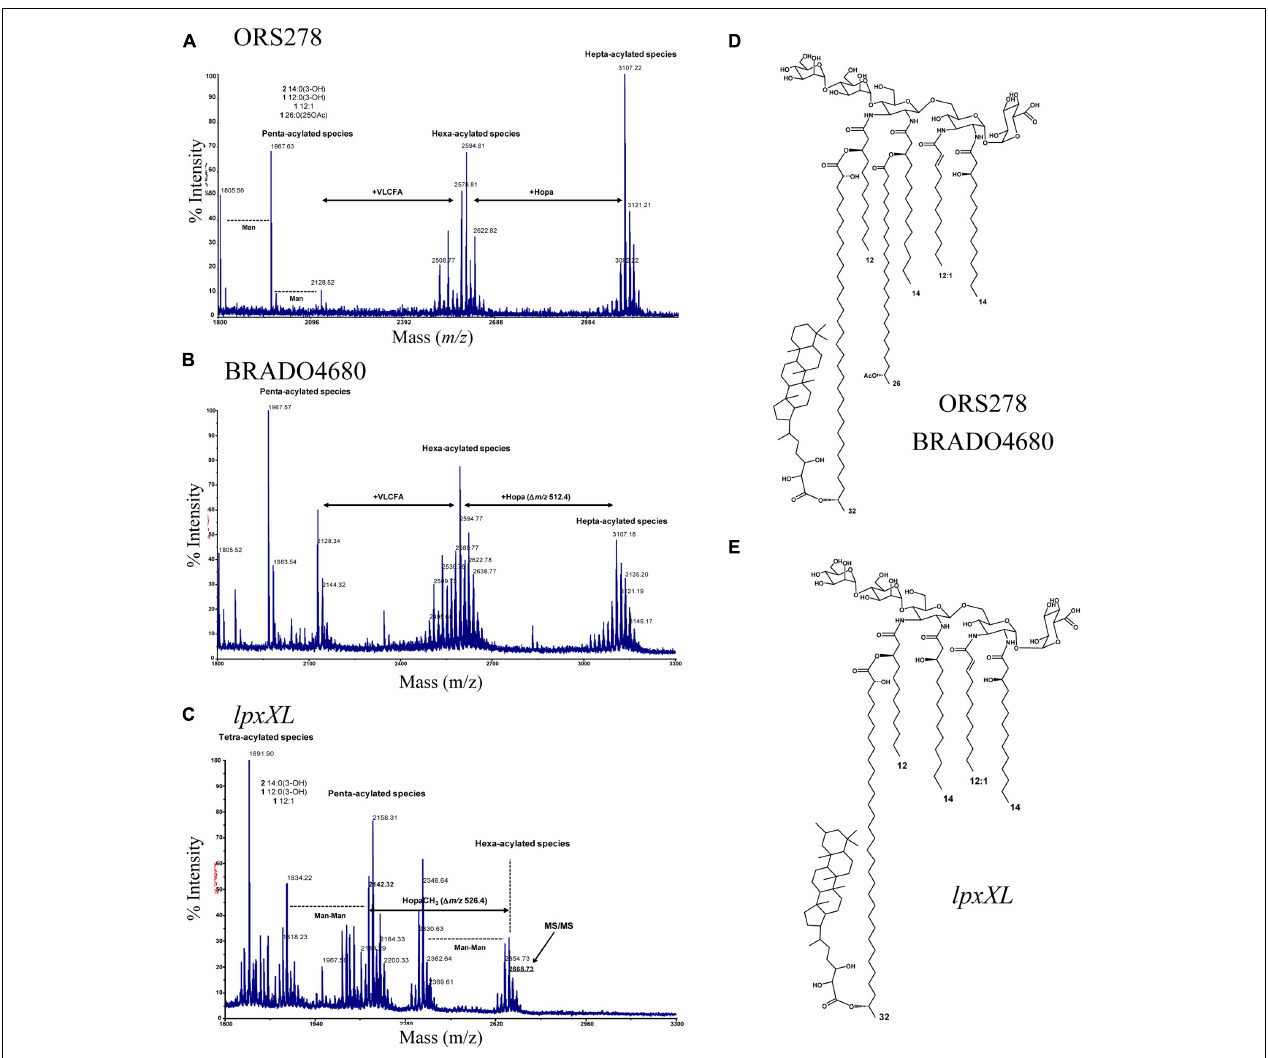
FIGURE 3 | BRADO4679 ( lpxXL ) is involved in the transfer of the C 26 :25OH VLCFA to the lipid A of ORS278. (A) MALDI mass spectrum of lipid A from Bradyrhizobium ORS278; (B) MALDI MS analysis of lipid A from Bradyrhizobium ORS278 (cid:49) 4680. The spectrum showed a series of intense sodiated molecular ions in the region between m/z 2400 and 2700, due to the hexa-acylated species carrying a VLCFA, and a further series of ions in the region between m/z 2900 and 3200 corresponding to hepta-acylated lipid A carrying a hopanoid unit ( (cid:49) m/z 512.4). The highest heterogeneity of lipid A from BRADO4680 is mainly due to variation of the chain length but not affecting the skeleton of the molecule. (C) MALDI mass spectrum of lipid A from Bradyrhizobium lpxXL mutant. The sodiated hexa-acylated lipid A, in the mass range between m/z 2500 and 3000, also comprised species carrying hopanoid moieties with an additional methyl-group ( (cid:49) m/z 526.4), as confirmed by the MS/MS analysis of the precursor ion at m/z 2668.73 (see Supplementary Figure S2). It is likely that methylation took place at C-2 of hopanoid residue, which frequently occurs under stress conditions and might play a key role in the permeability of the membrane. Proposed lipid A structures of ORS278 and BRADO4680 mutant (D) and lpxXL mutant (E) . The C 26 :25OH VLCFA was not observed in the lpxXL mutant of